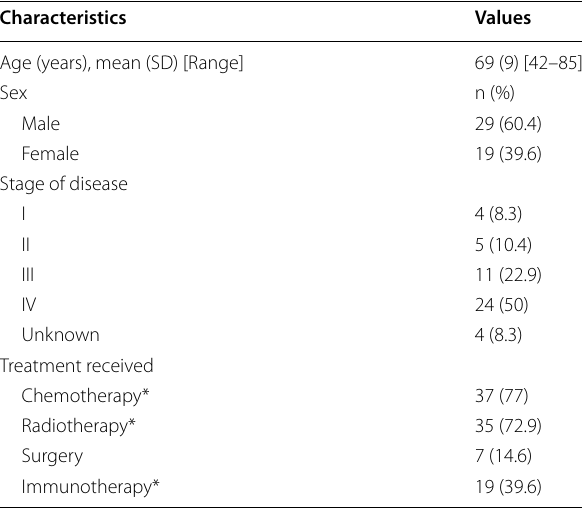
Table 2 Characteristics of onboarded